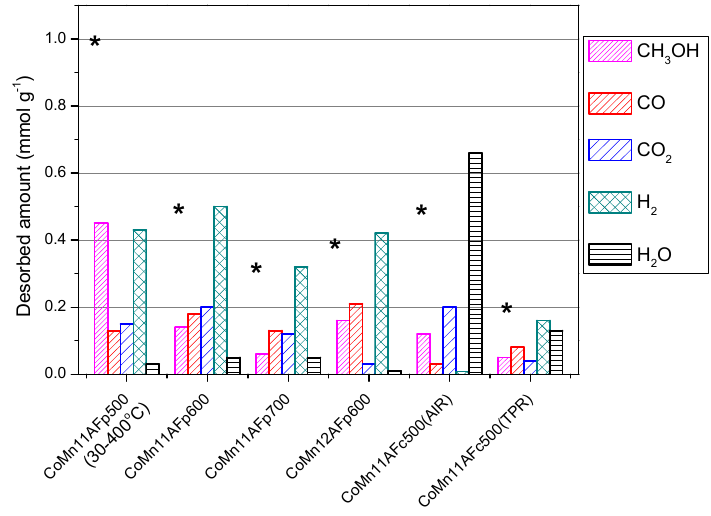
Figure 12. Desorbed amounts of CH 3 OH, CO, CO 2 , H 2 and H 2 O during TPD after CH 3 OH adsorption. Adsorbed amount of methanol is shown with asterisks (*).